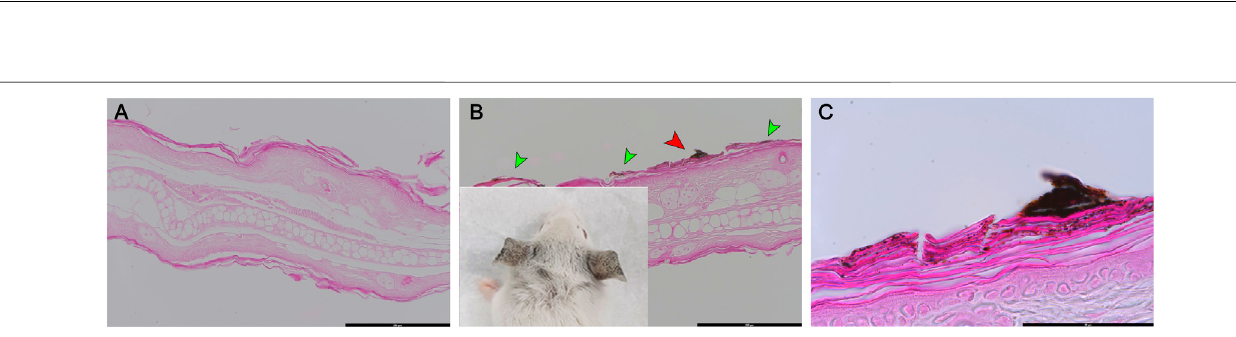
FIGURE 5 | Induction of stimulation index (SI) in the LLNA: BrdU-FCM assay. Animals were administered fi ve metal oxide NPs: (A) CoO, (B) Co 3 O 4 , (C) CuO, (D) NiO, and (E) TiO 2 NPs. Data are expressed as mean ± standard deviation values (n (cid:2) 4). Signi fi cance vs. vehicle control: **** p < 0.0001.